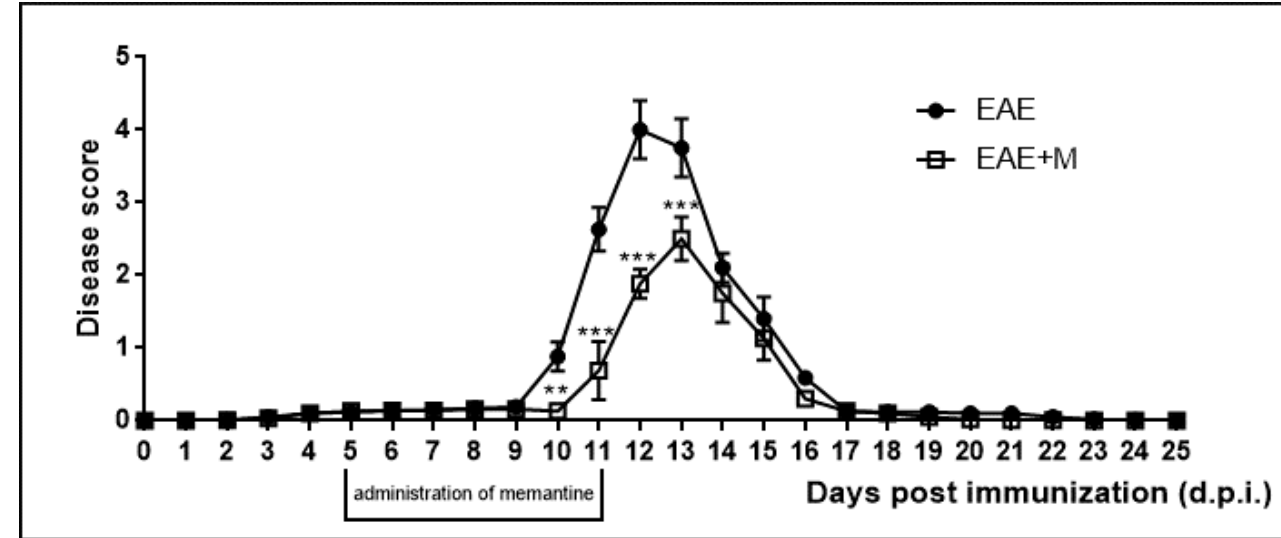
Figure 1. Scores of the neurological symptoms in experimental autoimmune encephalomyelitis (EAE) and memantine-treated EAE rats in different phases of the disease between 0 and 25 days post immunization (d.p.i.). Memantine was administered at a dose of 60 mg/kg b.w./day from 5 to 11 d.p.i. The values indicated neurological scores ± S.D. Results are Table 2. Characteristics of the EAE model and the clinical parameters of EAE rats prior to and after treatment with memantine. Characteristics/Clinical Parameters Animals with clinical symptoms (%)